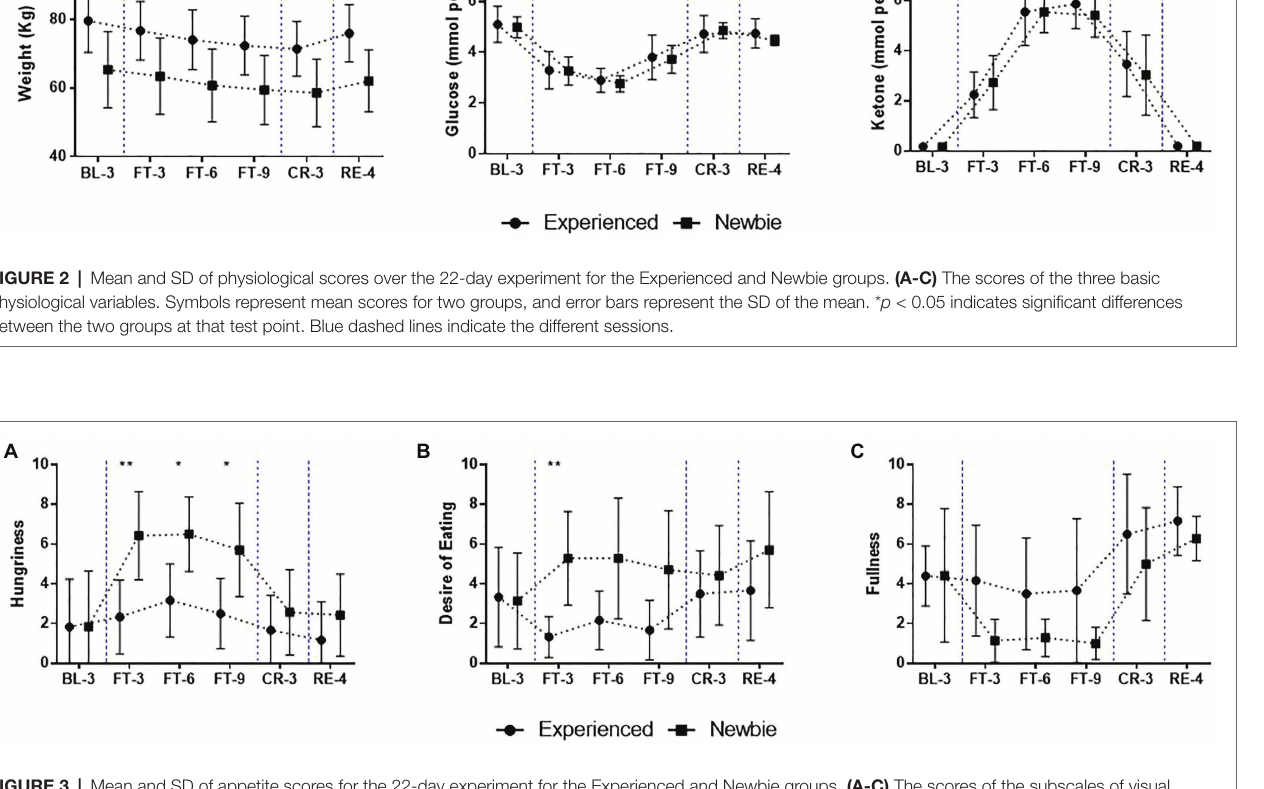
FIGURE 3 | Mean and SD of appetite scores for the 22-day experiment for the Experienced and Newbie groups. (A-C) The scores of the subscales of visual analog scale. Symbols represent mean scores for the two groups, and error bars represent the SD of the mean. * p < 0.05 and ** p < 0.01 indicate significant differences between the two groups at a given test point. Blue dashed lines indicate the different